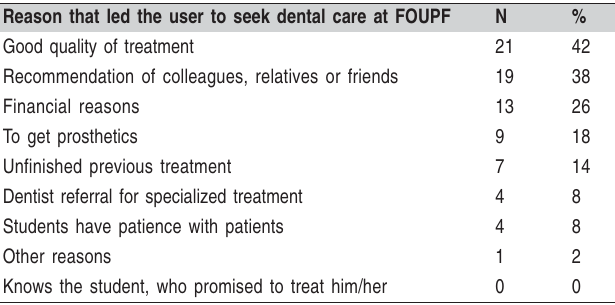
Table 1 - Reasons for patients to seek dental care at FOUPF